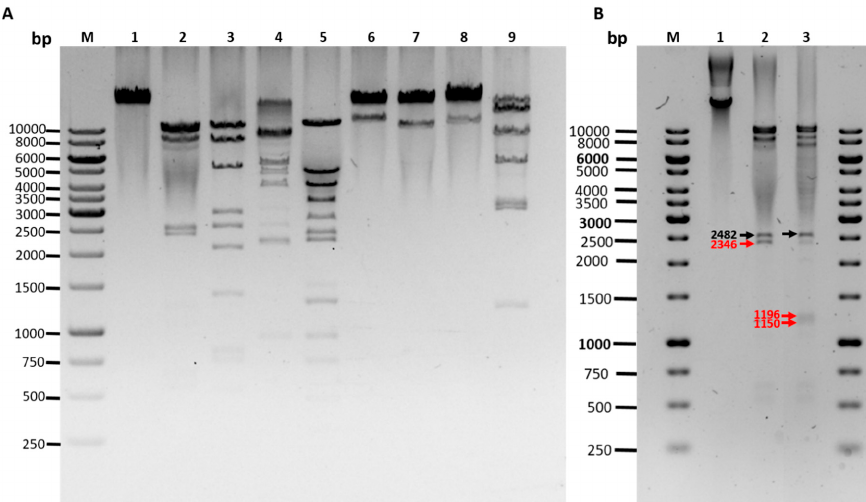
Figure 3. Agarose-gel-electrophoresis analysis of restriction enzyme digested fEgAba01 DNA. Panel ( A ) fEg-Aba01 genomic DNA digested with Eco RI (lane 2), Hin cII (lane 3), Nsi I (lane 4), Pst I (lane 5), SaI I (lane 6), Sca I (lane 7), Sex AI (lane 8), and Spe I (lane 9). Lane 1, undigested DNA. Lane M, 1-Kb DNA ladder. Panel ( B ), confirmation of the cohesive ends. Lanes: 1, undigested phage DNA; lane 2, Eco RI-digested DNA, the red arrow indicates the joint fragment; lane 3, Eco RI-digested phage DNA, heated after digestion at 80 ◦ C for 15 min, followed by rapid cooling to room temperature (RT). The red arrows indicate the left and right end Eco RI fragments. The black arrows indicate the 2482 bp